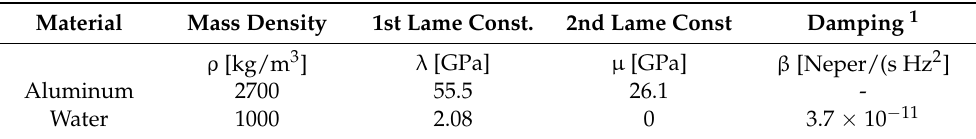
Table 1. The model material properties for the elastic wave propagation